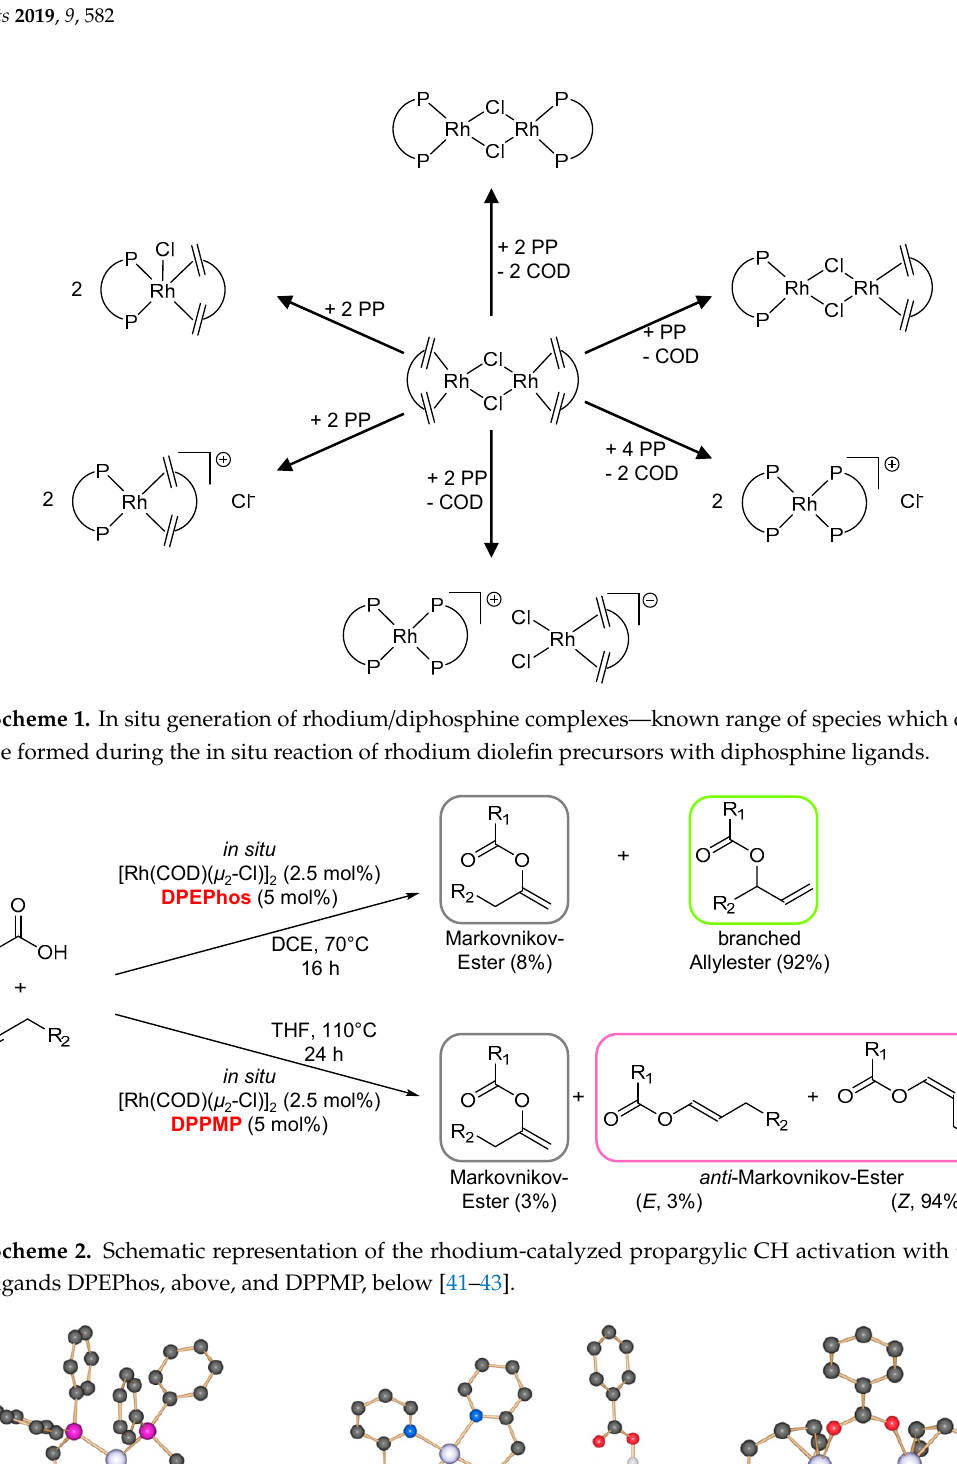
Scheme 2: Schematic representation of the rhodium-catalyzed propargylic CH activation with the ligands DPEPhos, above, and DPPMP, below [41–43].